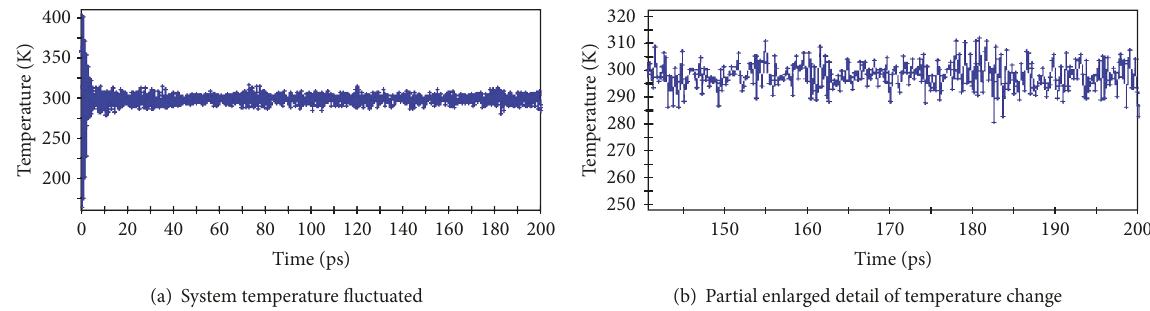
Figure 4: Change graph of temperature with simulation time after NPT dynamics